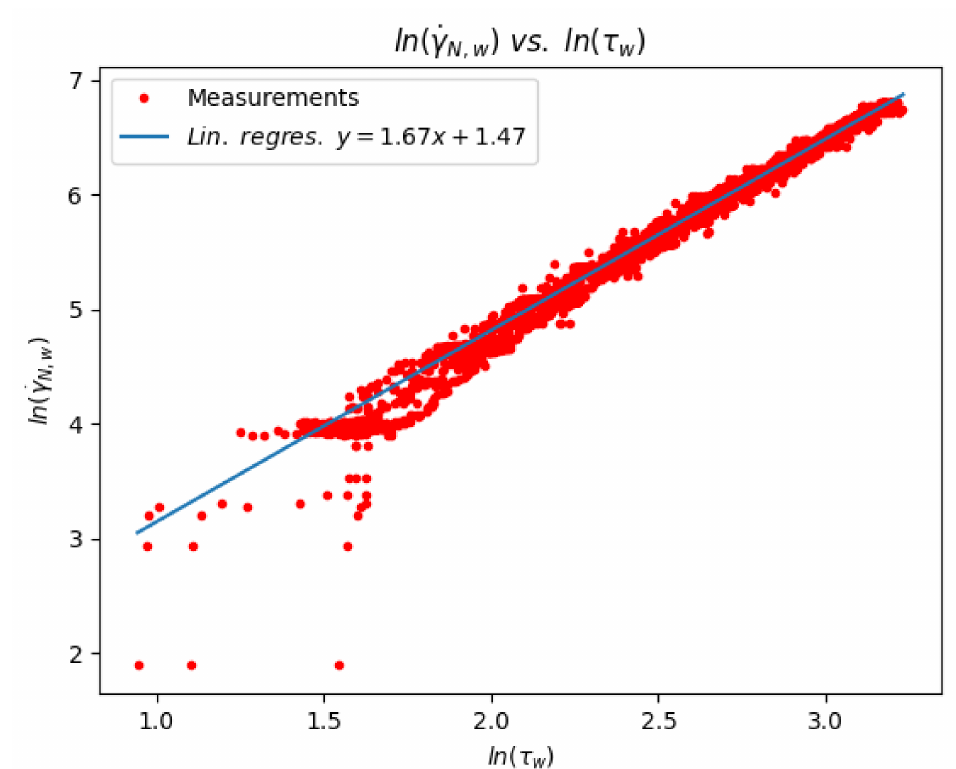
. γ N , w is expressed in